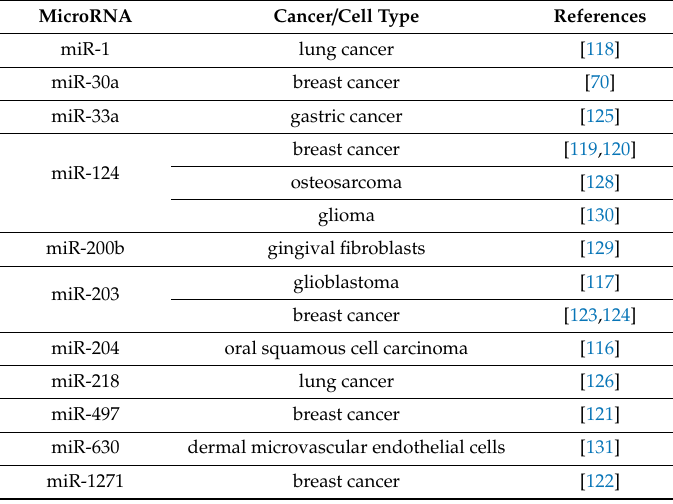
Table 3. MicroRNAs regulating